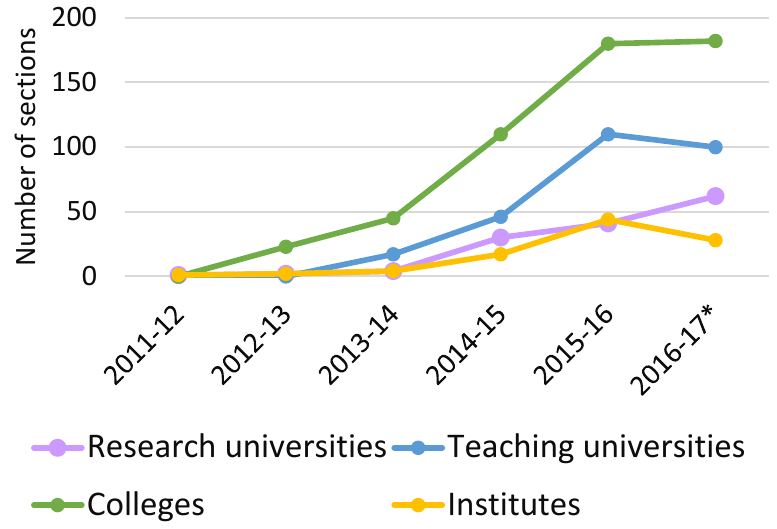
Figure 3. Open textbook adoptions by academic year by type of institution. Adoption data from 2016-17 does not include Summer 2017 sections.